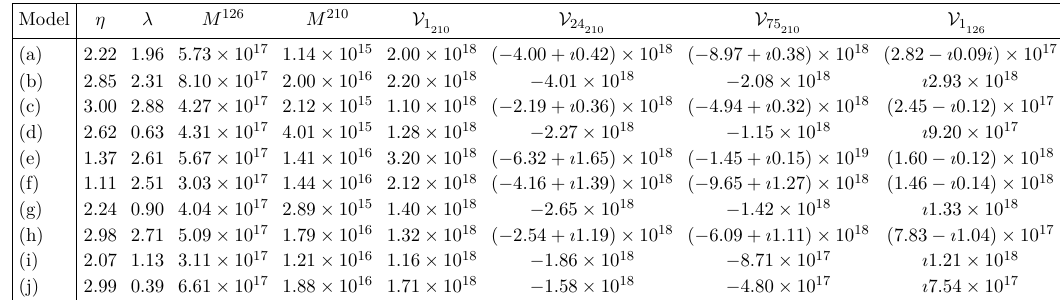
Table 1 . A numerical estimate of the VEVs of the Standard Model singlets in 210 , 126 and 126 - plets arising in the spontaneous breaking of the SO( 10 ) GUT gauge symmetry under the assumption V 1 = V 1 . All VEVs and masses are in 126 126